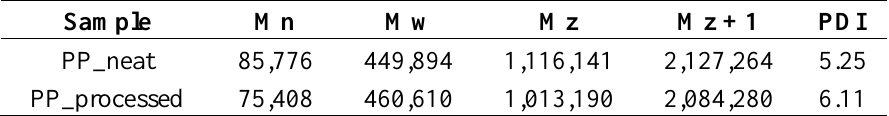
Table 3. Moments of the MWD and polydispersity indices for the PP resins before and after processing.